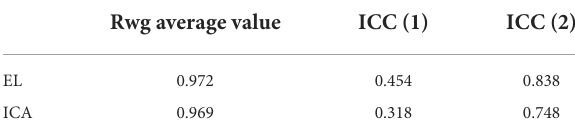
TABLE 1 Team variables Rwg mean value, ICC (1), ICC